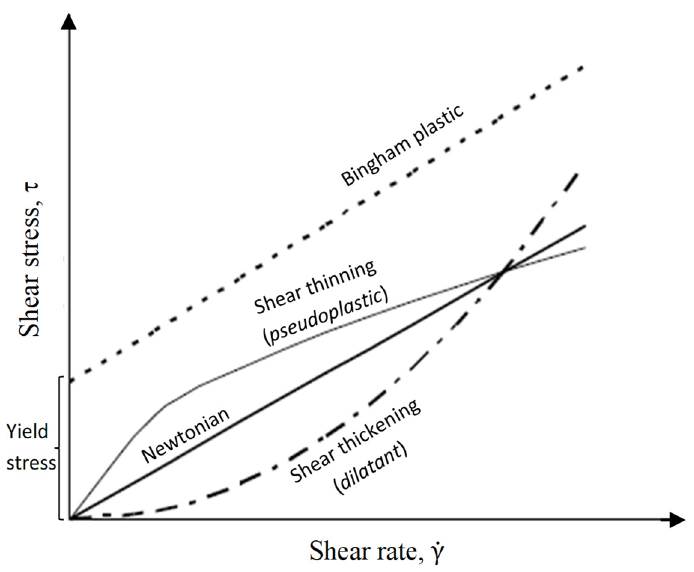
Figure 1. Shear stress-dependent on the shear rate in fluids.